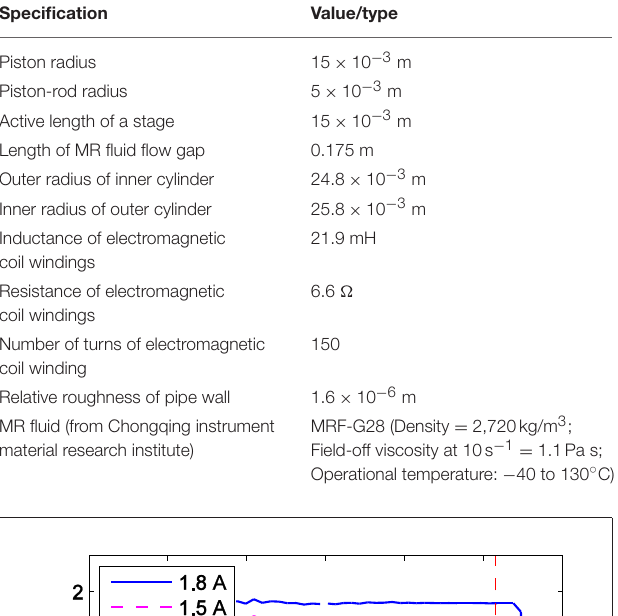
TABLE 1 | Geometries and parameters of the self-developed double-rod MR damper.